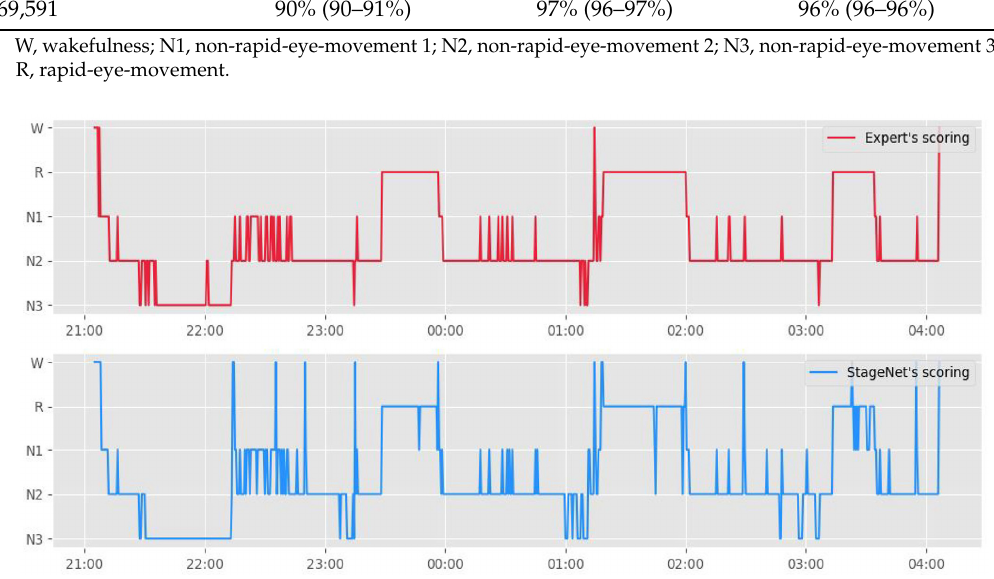
Table 2. Bootstrapped point ‐ estimate of median percent agreement (%) with a 95% bootstrap confi ‐ dence interval.